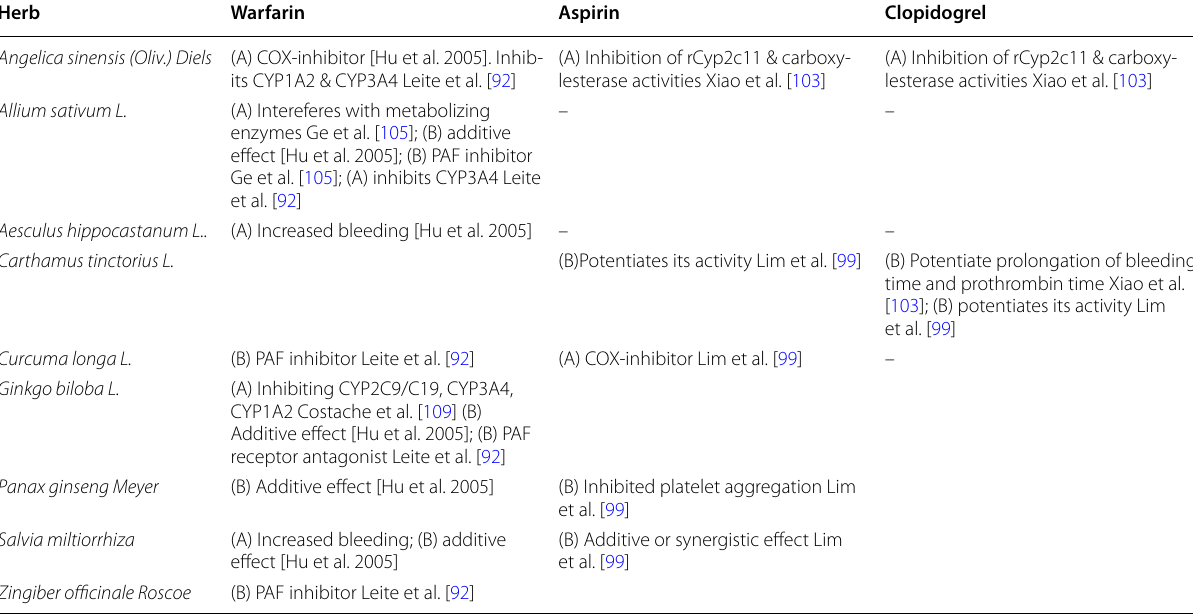
Panax ginseng Meyer Salvia miltiorrhiza Zingiber officinale